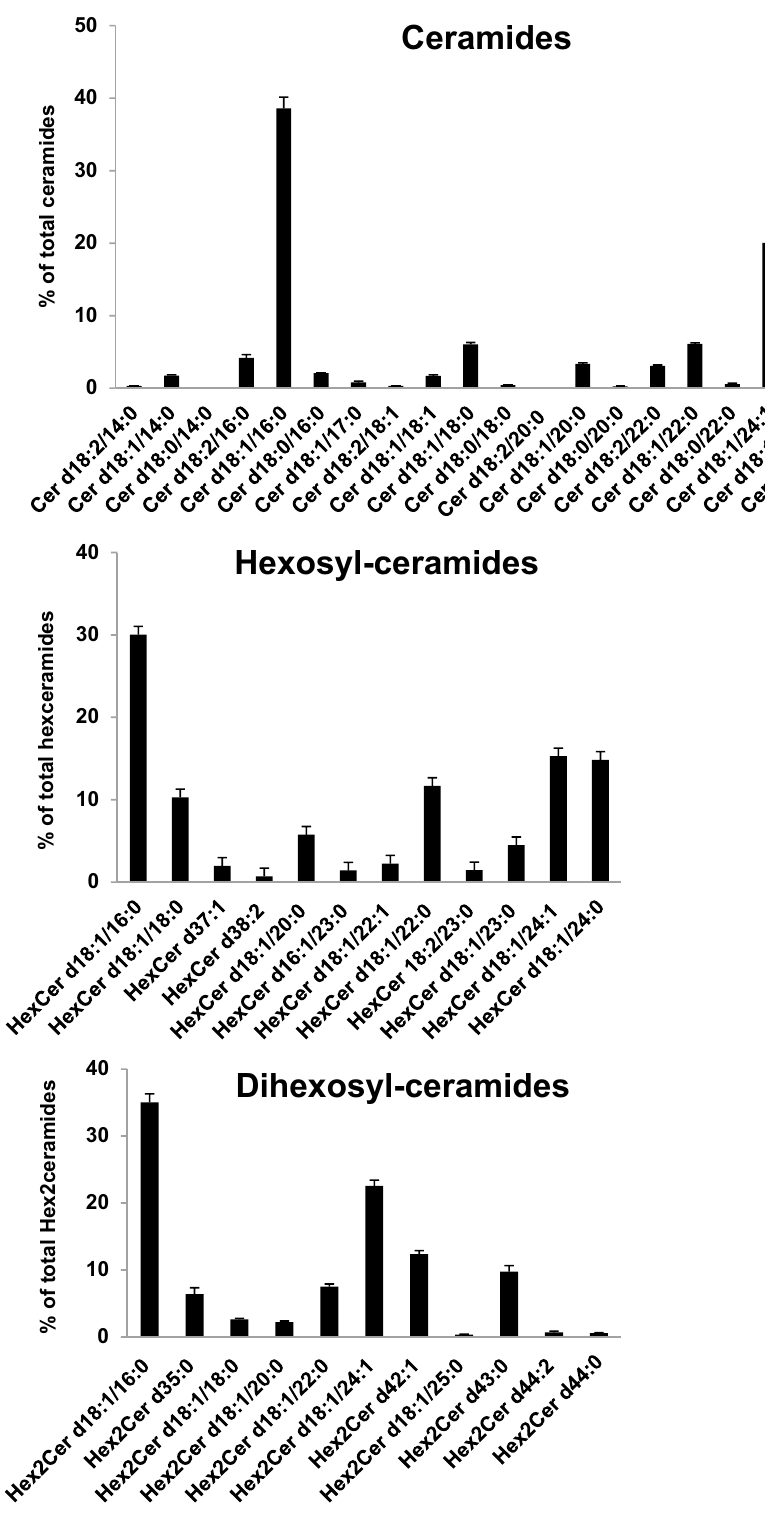
Figure 4. Concentrations of individual ceramide, hexosyl-ceramide and dihexosyl-ceramide species identified in human nasal mucosa. Values are presented as the mean ± sem (n =